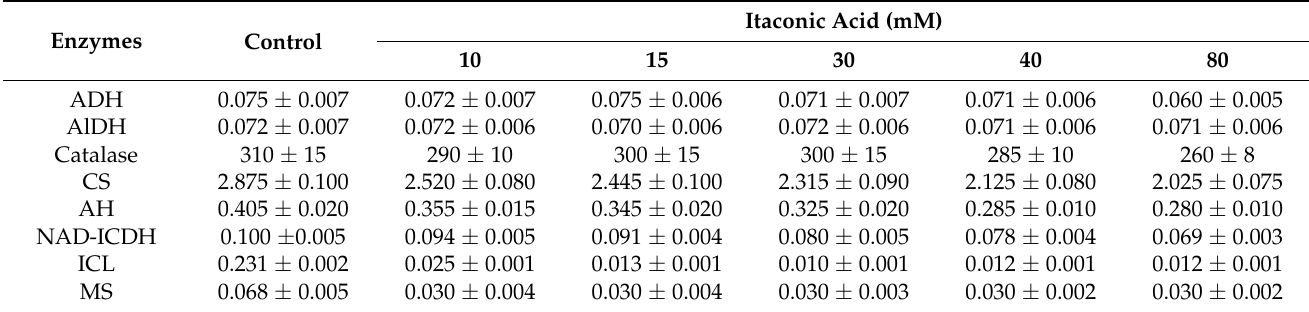
Table 2. Effect of itaconic acid on the enzyme activities (U/mg protein) of Y. lipolytica VKM Y-2373.